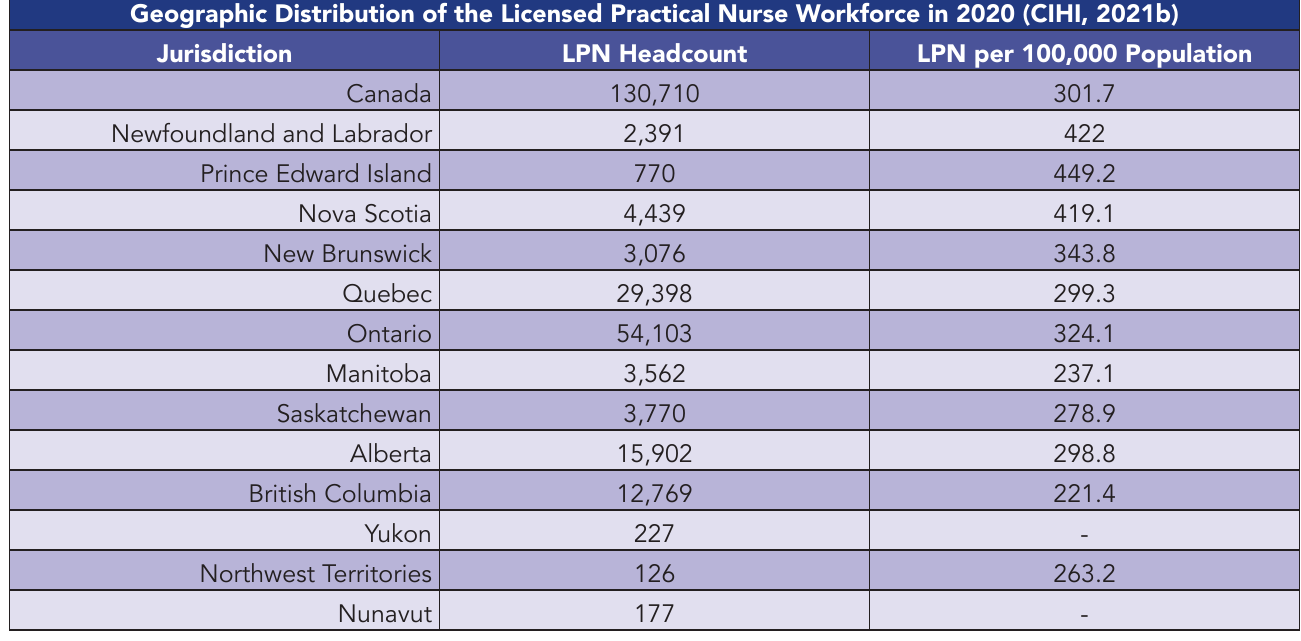
Table 4. The geographic distribution of the Licensed Practical Nurse workforce in 2020 Geographic Distribution of the Licensed Practical Nurse Workforce in 2020 (CIHI,